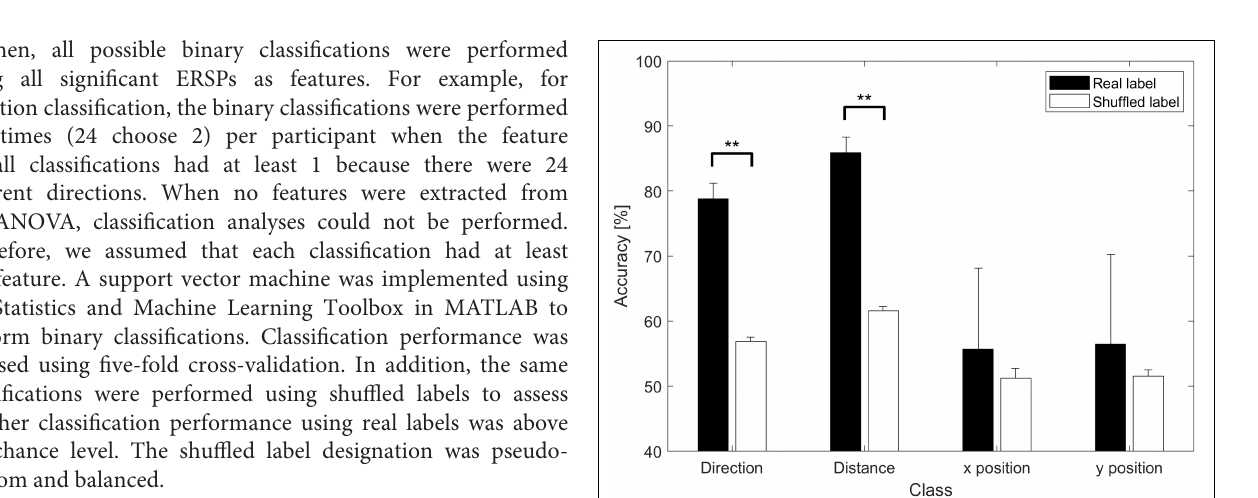
FIGURE 3 | EEG signal processing. After performing an independent component analysis (ICA), ERSPs of each independent component (IC) were calculated for each trial using EEGLAB. Then, 1,500 ERSP values were obtained at each frequency at each time point in each IC (since there were 1,500 trials). We performed classification analyses using different class labeling depending on movements (i.e., 30 movements) and parameters (i.e., 24 directions, 7 distances, and 5 horizontal and vertical positions). Then, we performed an ANOVA using the 1,500 ERSP values at each frequency at each time point in each IC. If p > 0.05, ERSP values at that time point at that frequency in that IC were excluded from further analyses. If significant, post hoc analyses were performed to find significant pairs. An ERSPs at a particular time and frequency in an IC was selected as a feature for subsequent binary classifications (for significant pairs). After this procedure was completed with respect to all ICs, frequencies, and times, binary classifications using significant ERSPs were performed. ANOVA, analysis of variance; Freq, frequency; ERSP, event-related spectral perturbations.